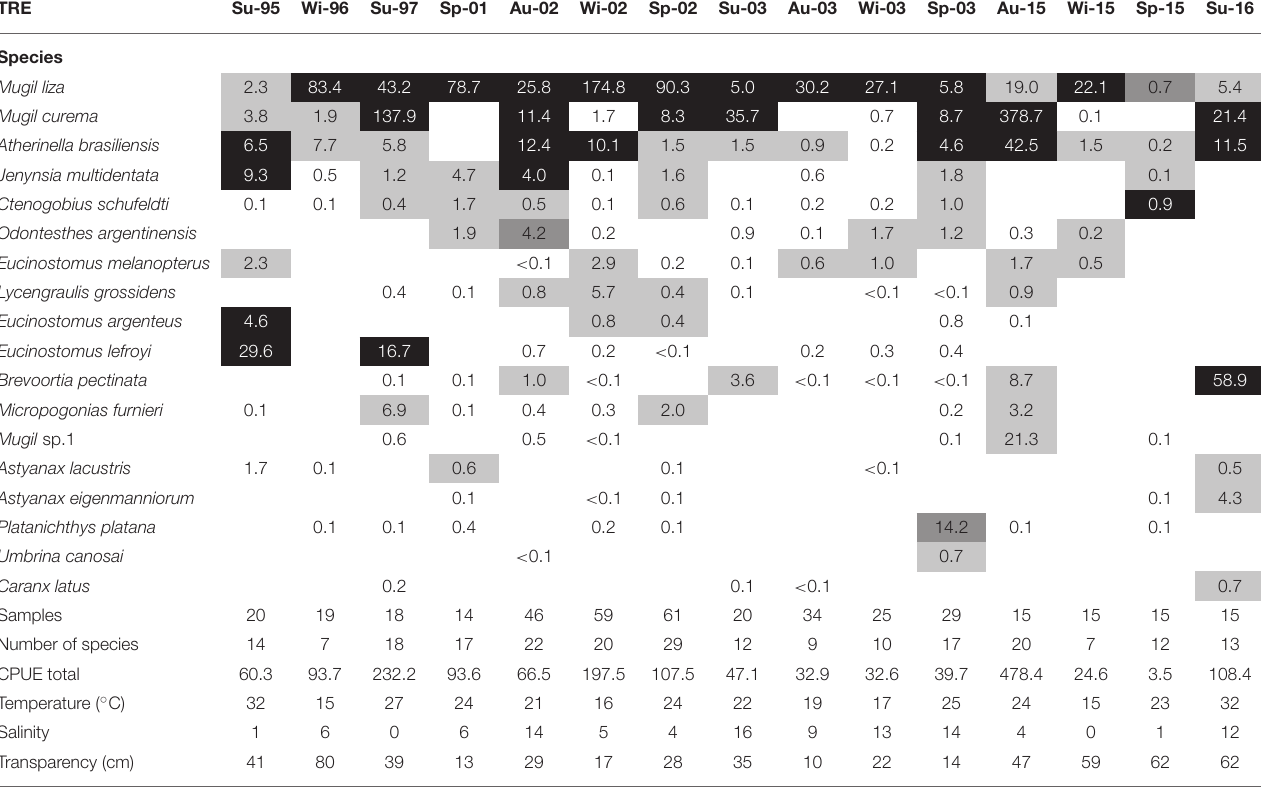
TABLE 2 | List of species caught per season per year in Tramandaí River estuary (TRE) and number of samples, number of species, total catch per unit effort (CPUE), mean temperature ( ◦ C), mean salinity, and mean transparency (cm). TRE Species Mugil